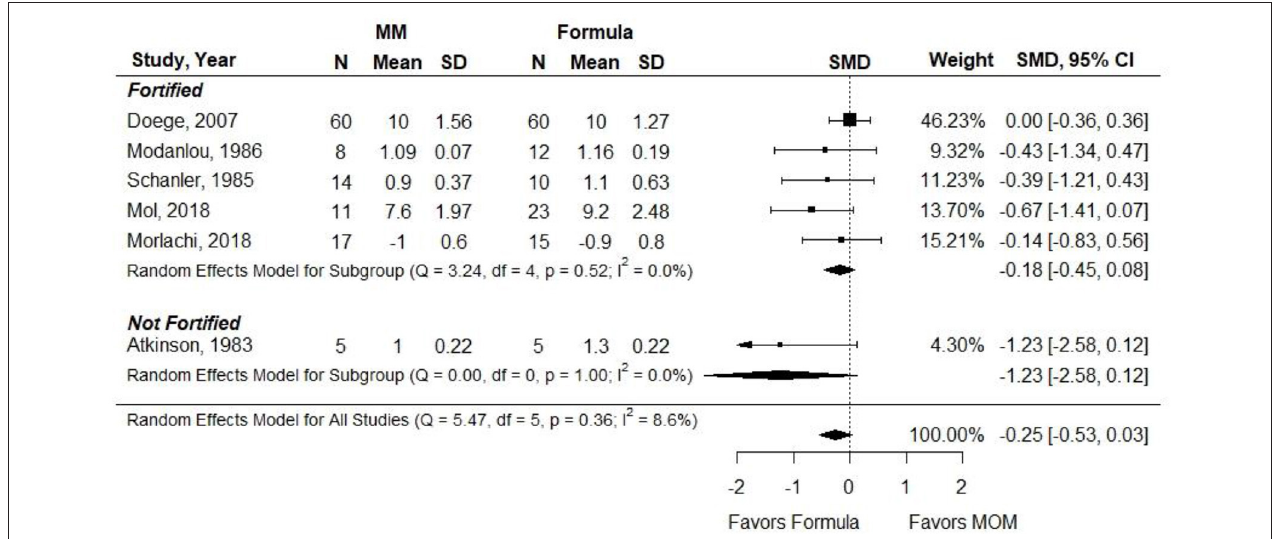
FIGURE 7 | Forest plot demonstrating SMD (95%CI) of Head circumference for VLBW preterm infants receiving ≥ 75% intake from Maternal Milk (MM) compared to exclusive formula